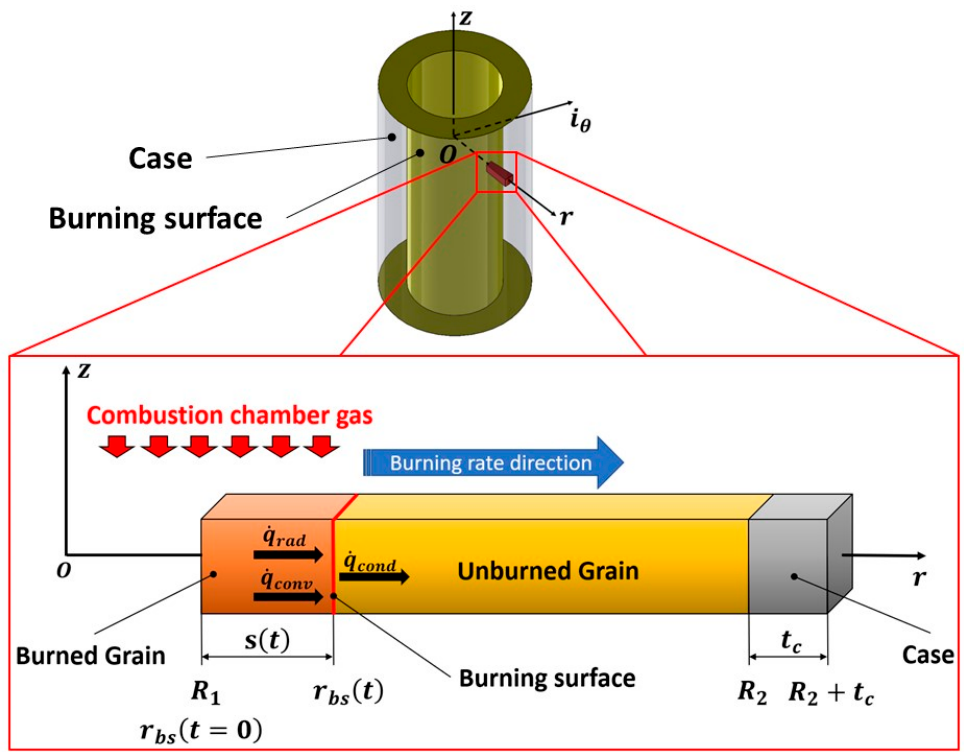
Figure 7. Mathematical–physical domain of the heat spreading across the propellant. Three heat transfer phenomena are considered across the burning surface. Two of them, namely radiation ( 𝑞(cid:4662) (cid:3045)(cid:3028)(cid:3031) , i.e., radiative power) and convection ( 𝑞(cid:4662) (cid:3030)(cid:3042)(cid:3041)(cid:3049) ) involve the heat flux coming from the combustion gaseous products in the motor chamber; on the . q contrary, conduction ( , i.e., conductive power) concerns the heat spreading through cond the grain/case sample. The heat produced by grain combustion is assumed to spread across the solid propellant driven by the following form of the heat equation (Equation